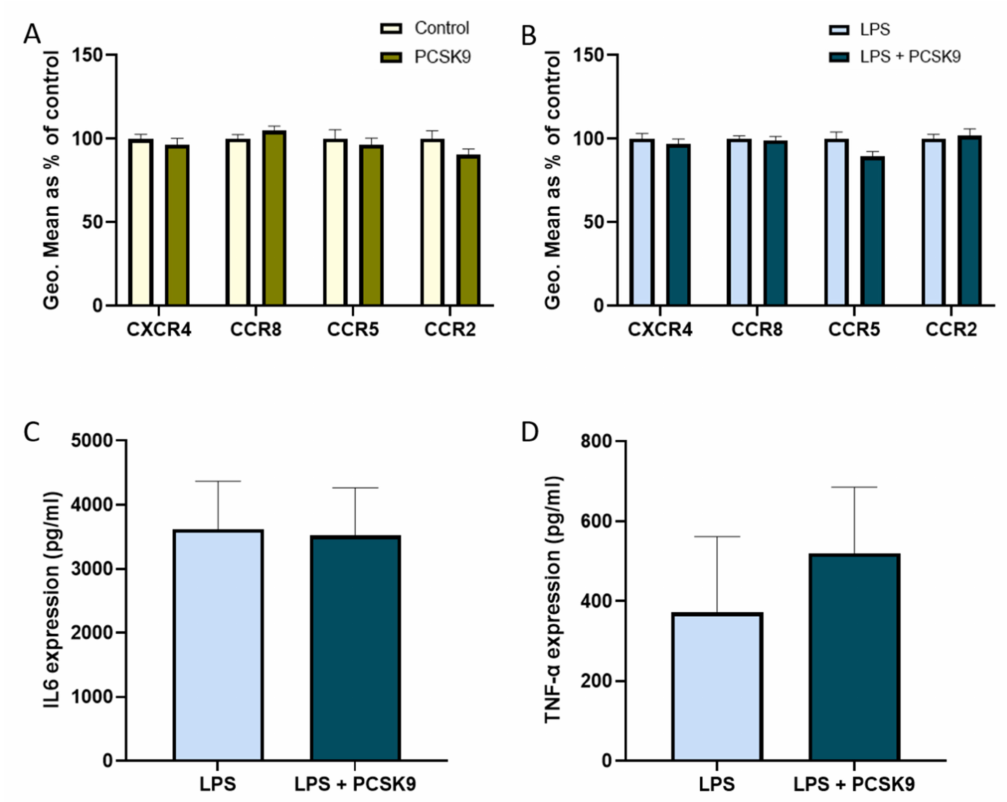
Figure 8. PCSK9 has no effect on the chemokine receptors and cytokines in human aortic smooth muscle cells. The expression of chemokine receptors CXCR4, CCR8, CCR5, and CCR2 were measured using flow cytometry and represented using geometric mean (Geo.Mean) in HAoSMCs ( n = 3–4 replicates) with and without PCSK9 ( A ) and when exposed to an inflammatory environment with LPS ( B ). Inflammatory cytokines IL6 ( C ) and TNF- α ( D ) expressions measured in the supernatant of the cell culture with and without PCSK9 in an inflammatory environment ( n = 3–4 replicates). Bar graphs are representation of mean ± SEM. 2-way ANOVA was used for ( A , B ) and thee Mann–Whitney test was used for ( C , D ) to calculate the statistical